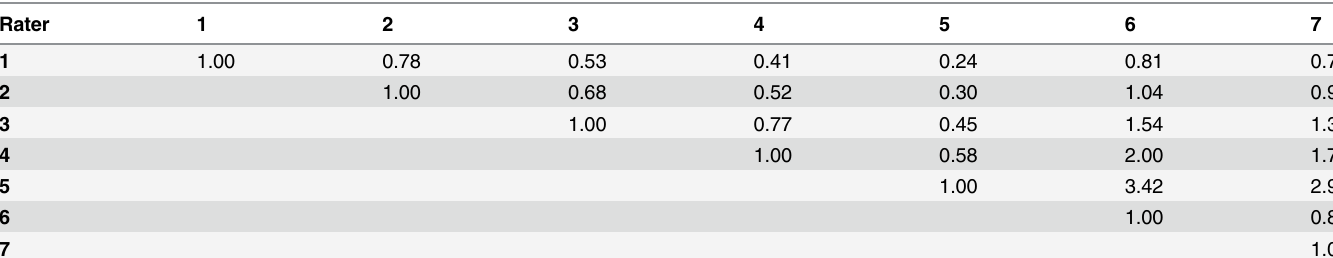
Ratios of the residual standard errors, displaying the ratio of column divided by row value of the residual error for each rater, as calculated in Table 2